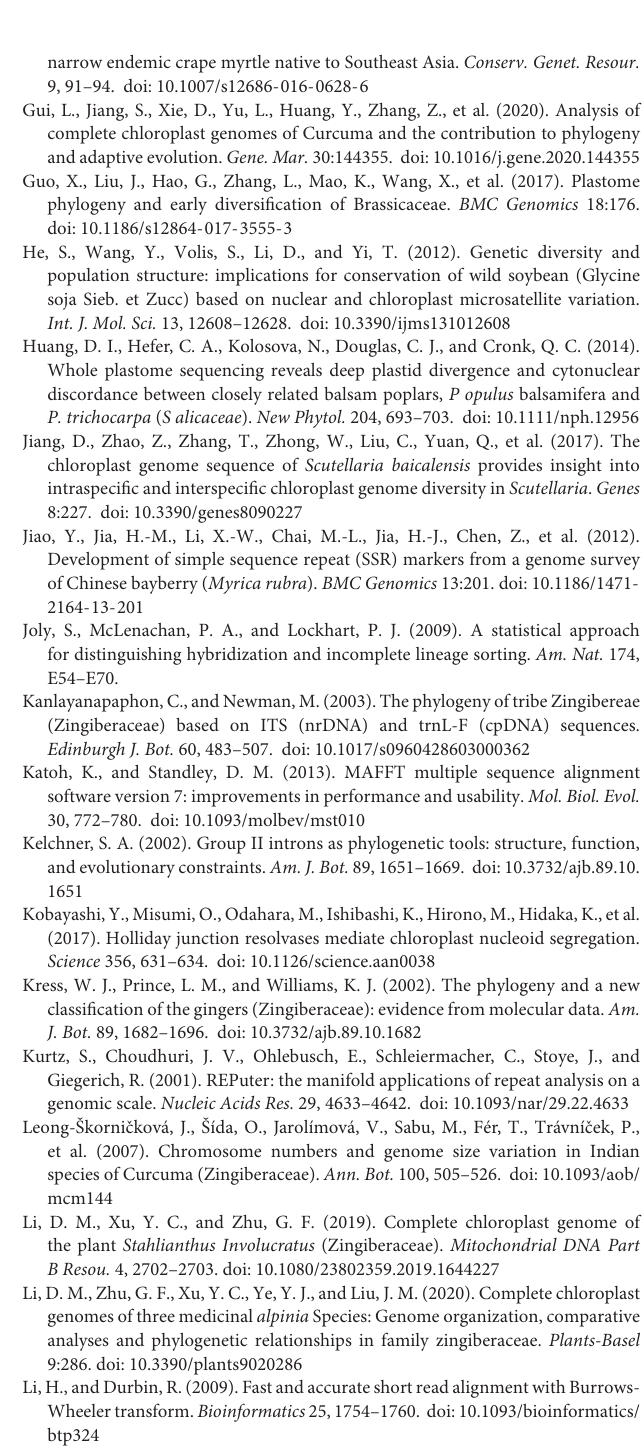
TABLE S3 | The genes having intron in the 25 Zingiberaceae chloroplast genomes. TABLE S4 | Codon content of amino acid and stop codon of 25 Zingiberaceae species. TABLE S5 | The rates of Ka, Ks.